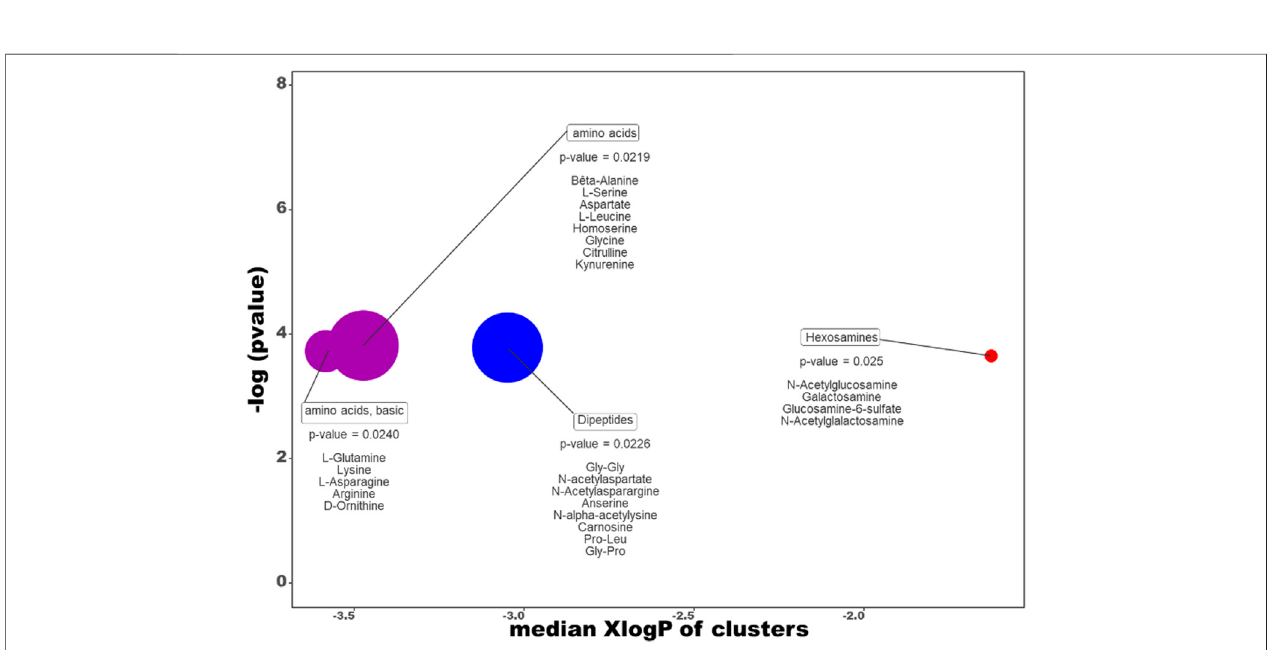
FIGURE 11 | ChemRICH diagram according to the dive effect. Each disc re fl ects a signi fi cantly altered family of metabolites. These groups are developed from chemical similarities highlighted by a hierarchical Tanimoto map (not shown) accessible in the ChemRICH program. Enrichment p -values are given by the Kolmogorov – Smirnov test. Disc sizes varies with the total number of metabolites. Blue or red discs present groups of underexpressed or overexpressed metabolites in Diver compared toCtrl rats,respectively. Purple colorrepresentsboth increasedand decreasedmetabolites. Forexample, thereare lessdipeptidesinthe fecesof the diver